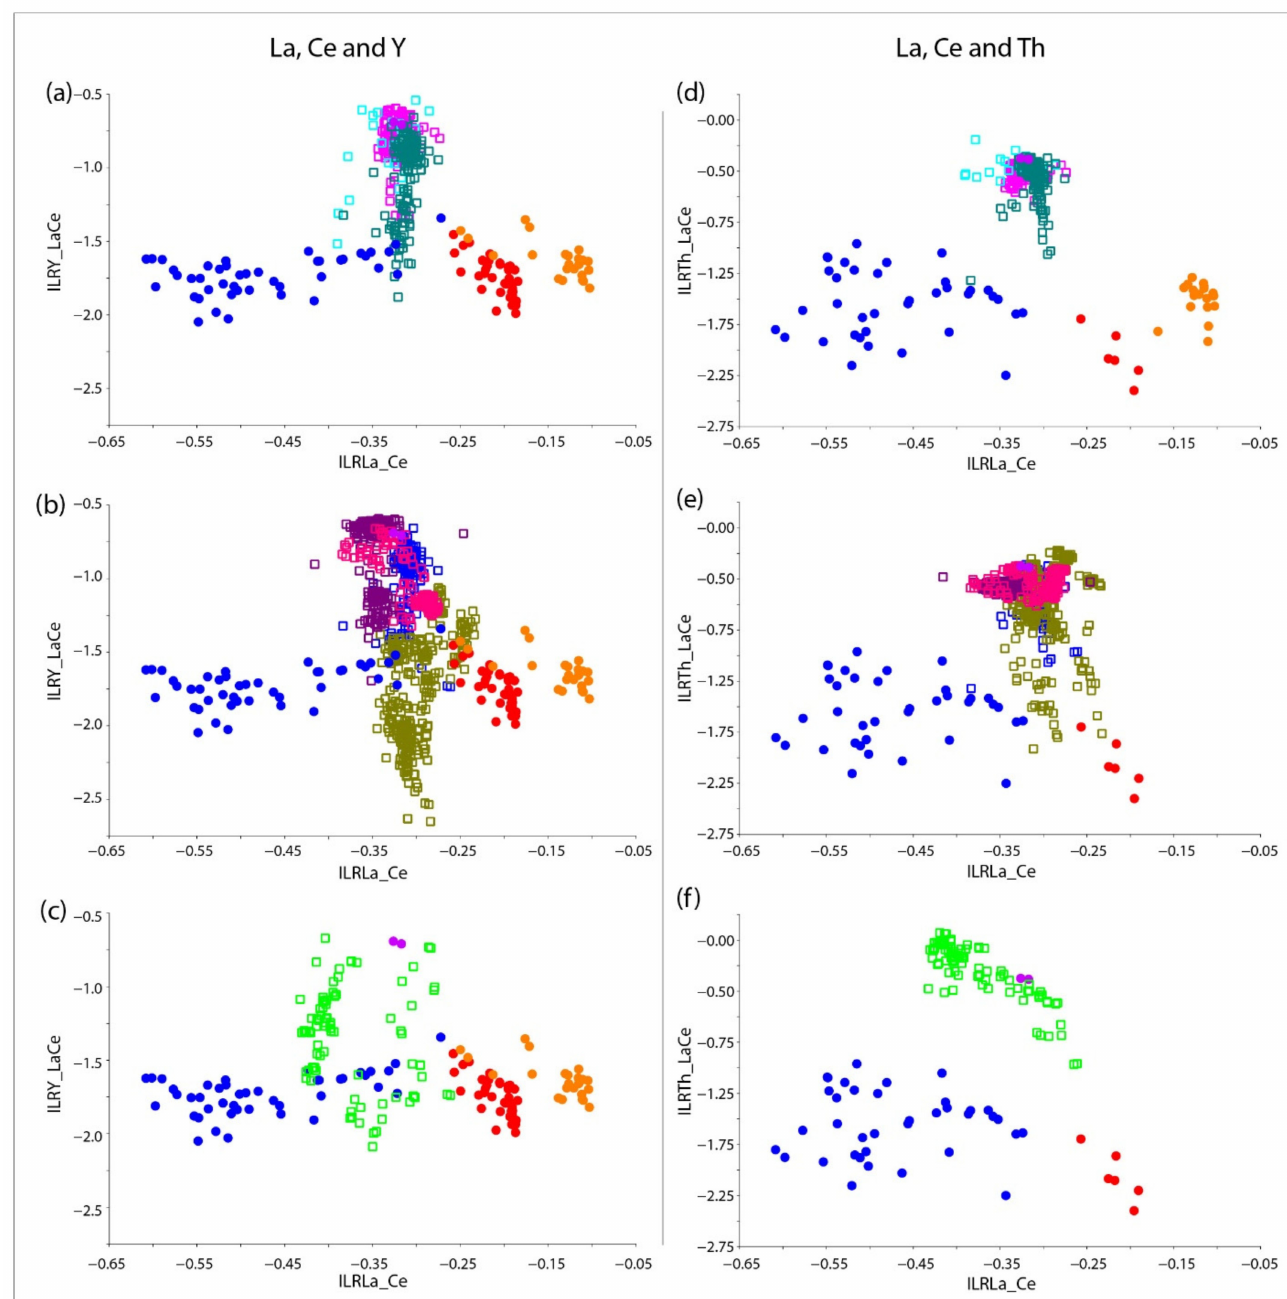
Figure 9. Isometric log ratio plots comparing La, Ce and Y ( a – c ) and La, Ce and Th ( d – f ) contents for metamorphic ( a , d ); shear zone hosted ( b , e ) and Challenger Au ( c , f ) monazite. Legend given in Figure